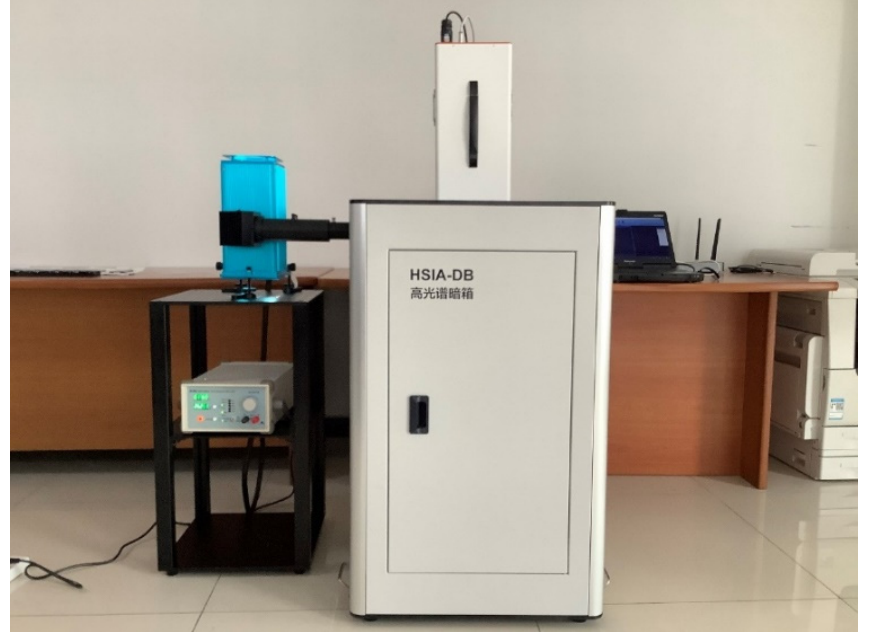
Figure 1. Fluorescence hyperspectral system.